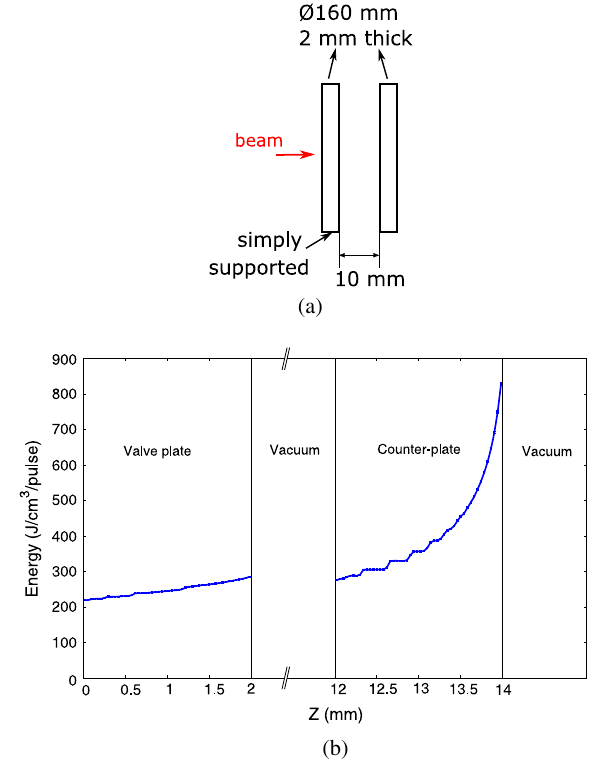
FIG. 3. (a) Schematic representation of the UHV sector valve. (b) Through-thickness energy deposition in the valve and counterplates along the beam axis after the impact of a proton beam